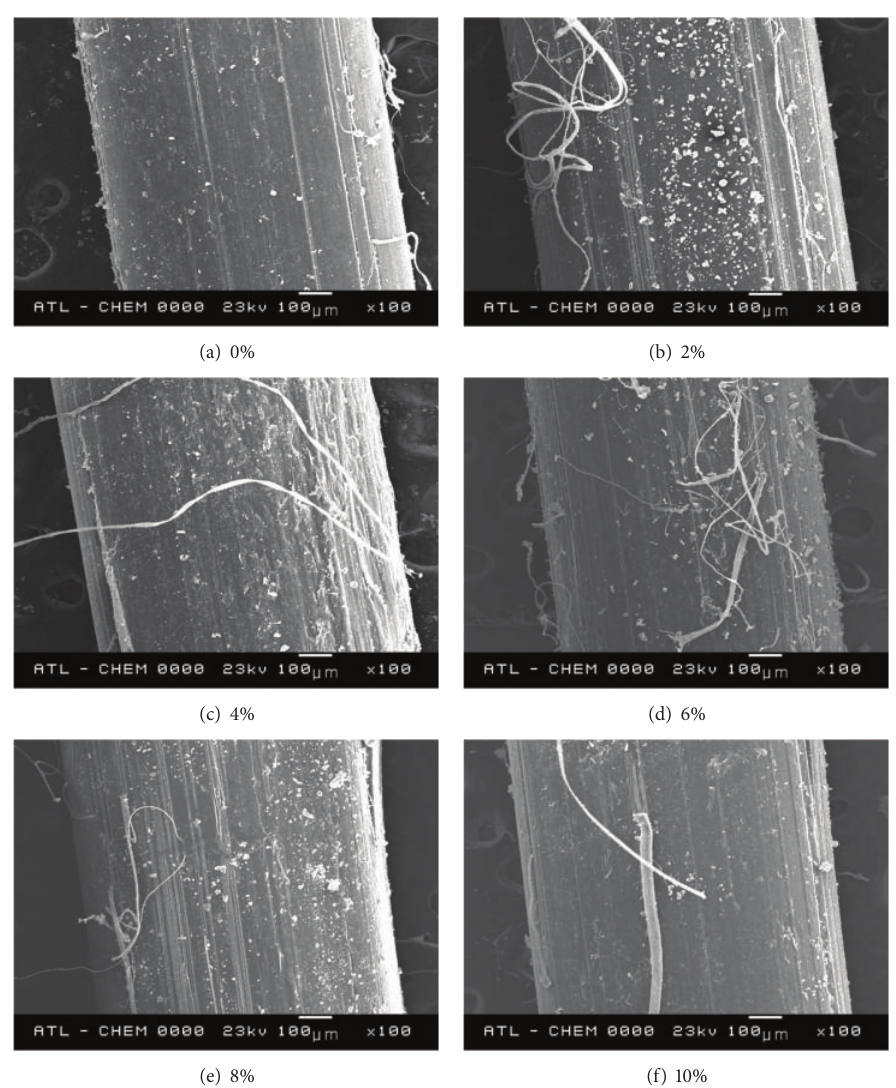
Figure 8: SEM investigation of macro PP fiber surface in PCC with nanosilica